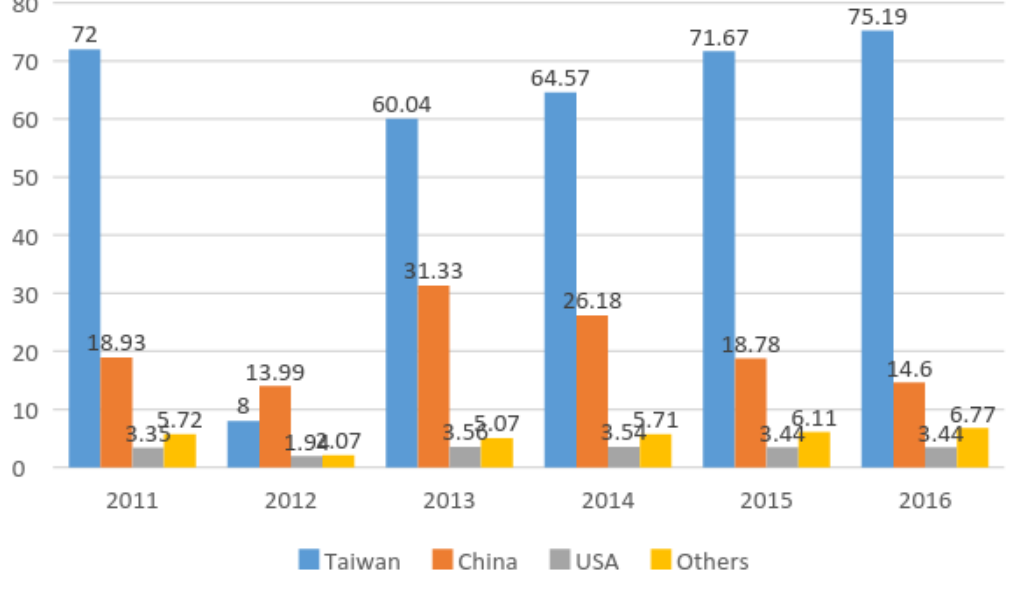
Figure 6. Demographical distribution of NTU OCW users.